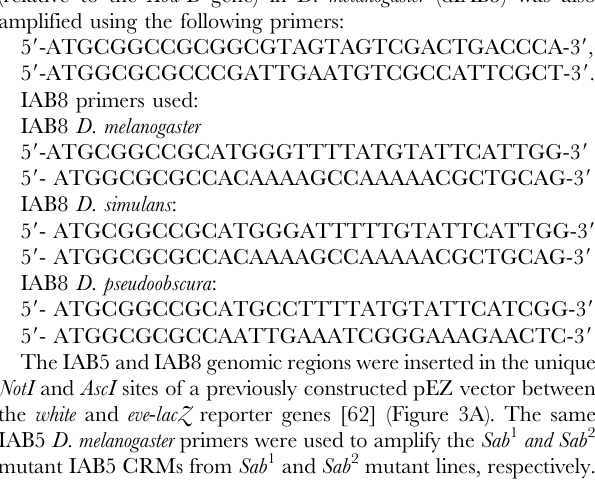
Figure S4 Bioinformatic analysis of TFBSs in the IAB7b genomic region. Transcription factor binding sites for FTZ (blue), KR (teal), KNI (yellow), EVE (purple), BCD (green), and HB (red) are shown below the DNA sequence. Regions of the sequence which are conserved between D. melanogaster and distantly related species as far as D. pseudoobscura are highlighted in gray. Putative sites with scores above the 99.5 percentile are shown next to predicted TFBS, with high-scoring sites (see Materials and Methods for descriptions) highlighted in bold.